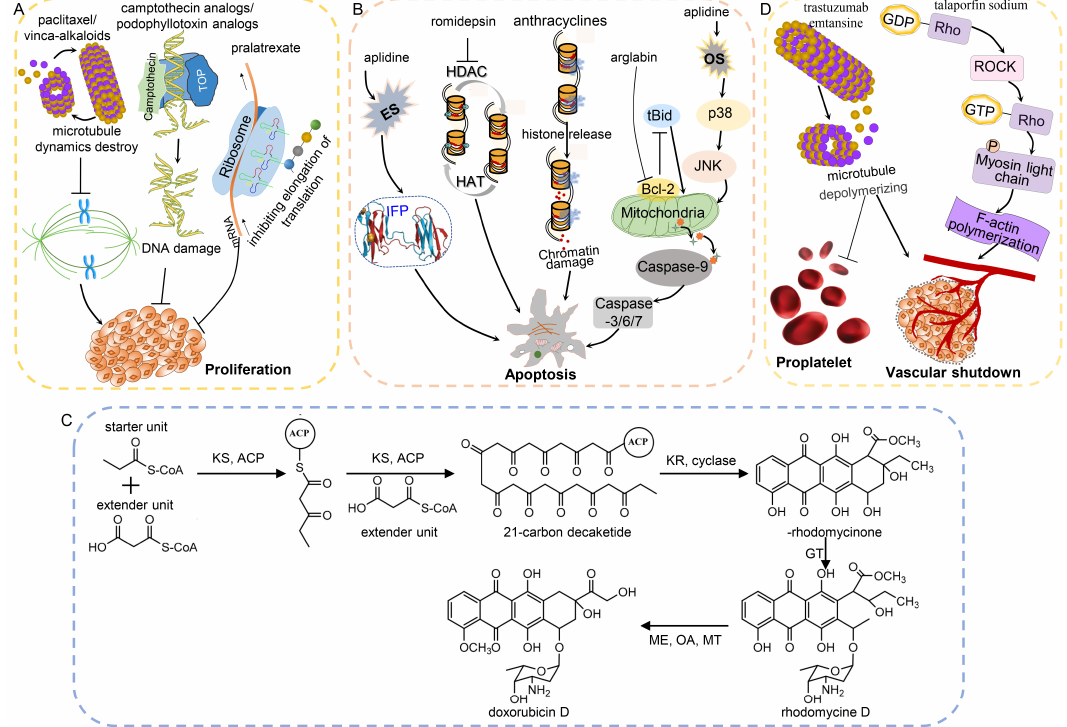
Figure 3. The main molecular mechanisms and regulation networks of anticancer drugs derived from natural products. ( A ) Natural products inhibit cell proliferation by destroying the microtubule dynamic and DNA damage and inhibiting translation. ( B ) Natural products induce apoptosis via mitochondrial pathway and chromatin damage and by destroying the balance of HAT and HDAC.